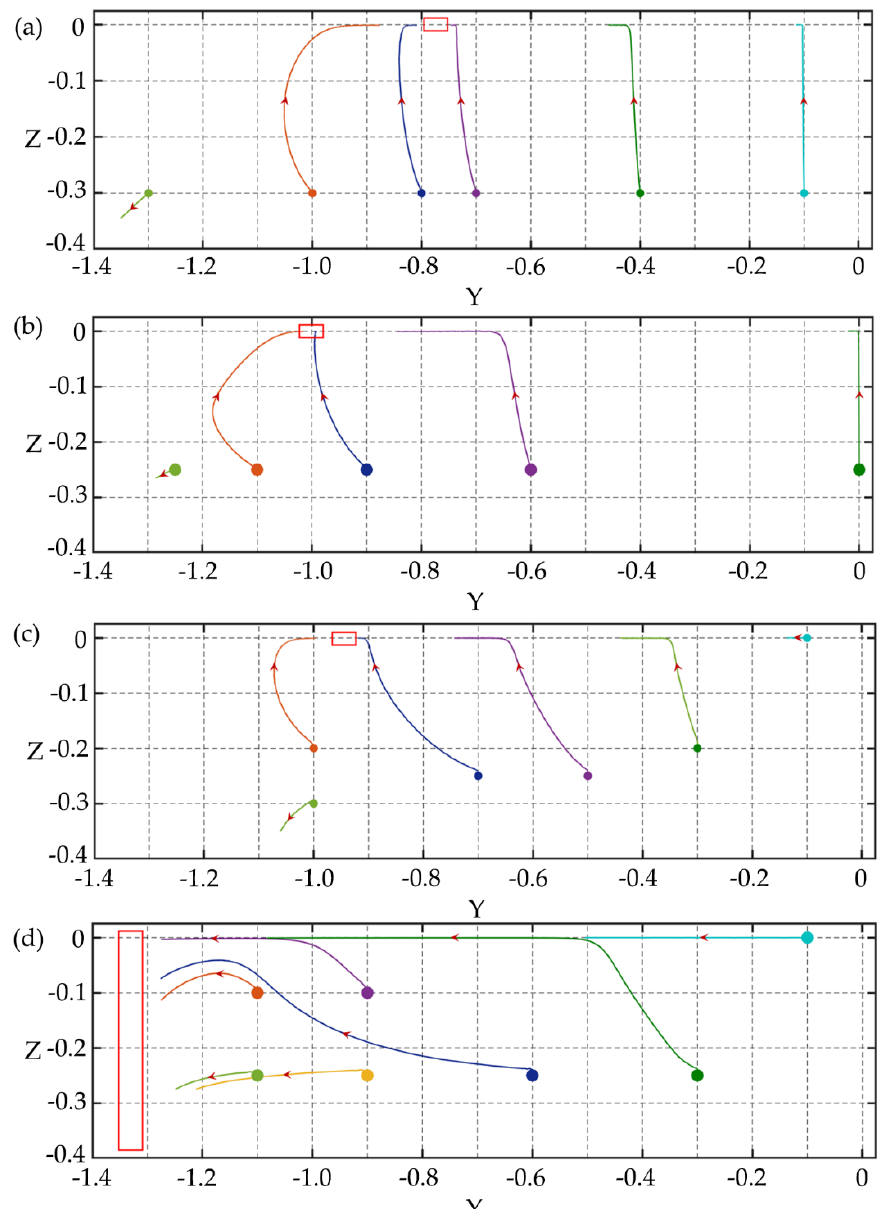
Figure 11. The migration trajectories of particles with different diameters in the channel with aspect ratio of AR = 1 / 3: ( a ) d / h = 0.15 under Re = 2.5 and Wi = 0.2; ( b ) d / h = 0.30 under Re = 2.5 and Wi = 0.2; ( c ) d / h = 0.15 under Re = 2.5 and Wi = 0.6; ( d ) d / h = 0.30 under Re = 2.5 and Wi = 0.6. The red boxes in